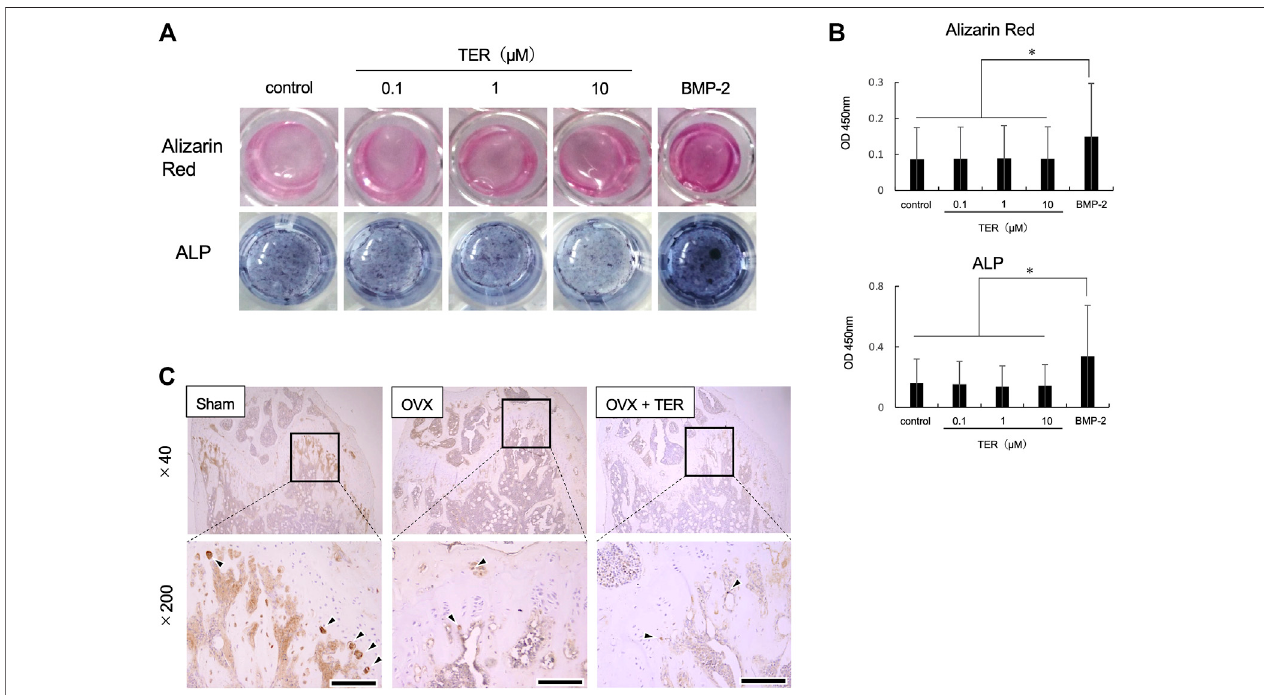
FIGURE 8 | Synthetic TER did not affect osteoblast differentiation. Mouse MC3T3-E1 cells (1.0 × 10 5 cells/well) were treated with ascorbic acid (50 μ g/ml) and hydrocortisone (10 μ M)/ β -glycerophosphate (10 mM)/bone morphogenetic protein 2 (BMP-2, 100 ng/ml) in the presence or absence of synthetic TER (0.1 – 10 μ M) for 3 weeks. (A) Osteoblast-stained image, alizarin red staining, and ALP staining. (B) Evaluation of calci fi cation and ALP activity ( n (cid:1) 3, mean ± SD, * p < 0.05, ANOVA/ Tukey – Kramer test). (C) IHC-stained (anti-ALP antibody) cells.